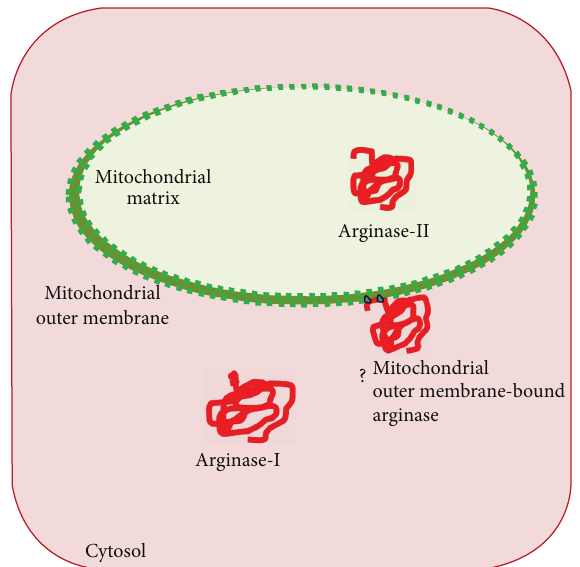
Figure 8: Illustration of presumed state of mitochondrial membrane-bound arginase. The question mark indicates the presence of mitochondrial membrane-bound arginase that may have been mistargeted due to posttranslational modification or alterations in the signal